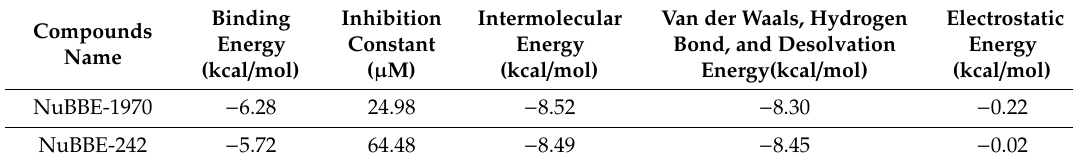
Table 2. Result of molecular docking of NuBBE-1970 and NuBBE-242 with active site of NSP15 by Autodock.